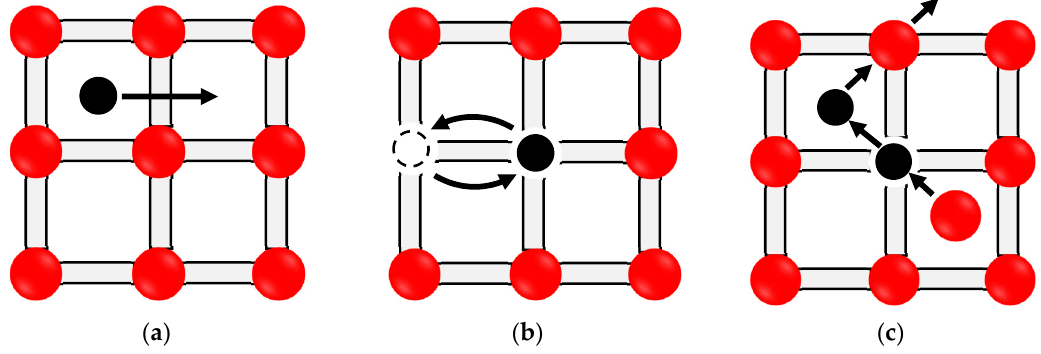
Figure 1. ( a ) Interstitial, ( b ) Vacancy and ( c ) interstitialcy diffusion mechanisms.